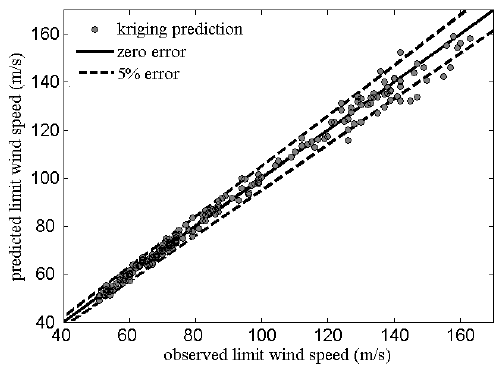
Figure 7. The comparison between the predicted result and the observation result.